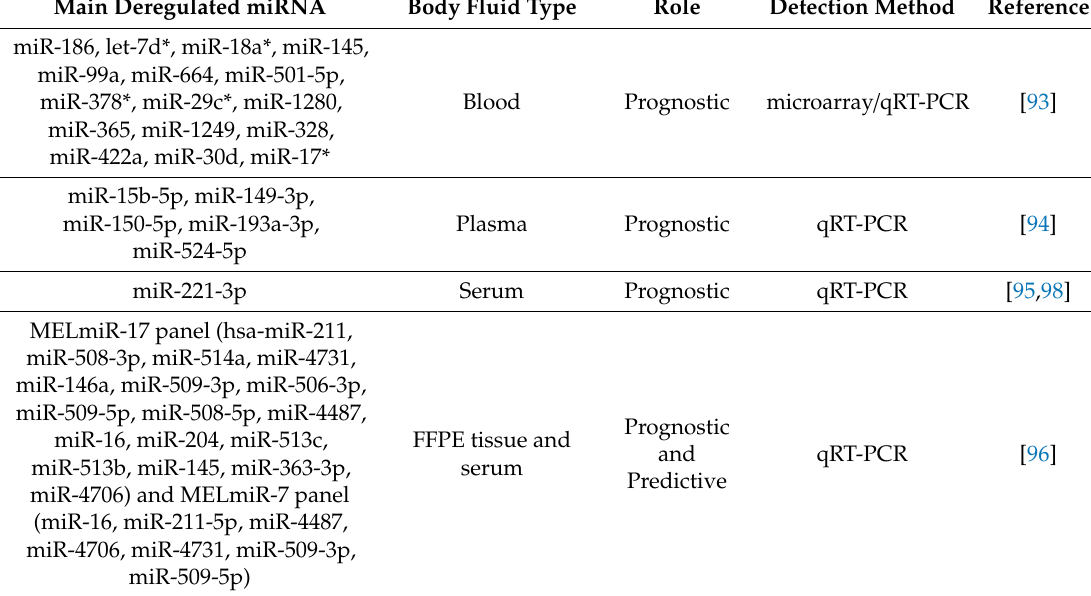
Table 1. Circulating miRNAs with a diagnostic and predictive role in